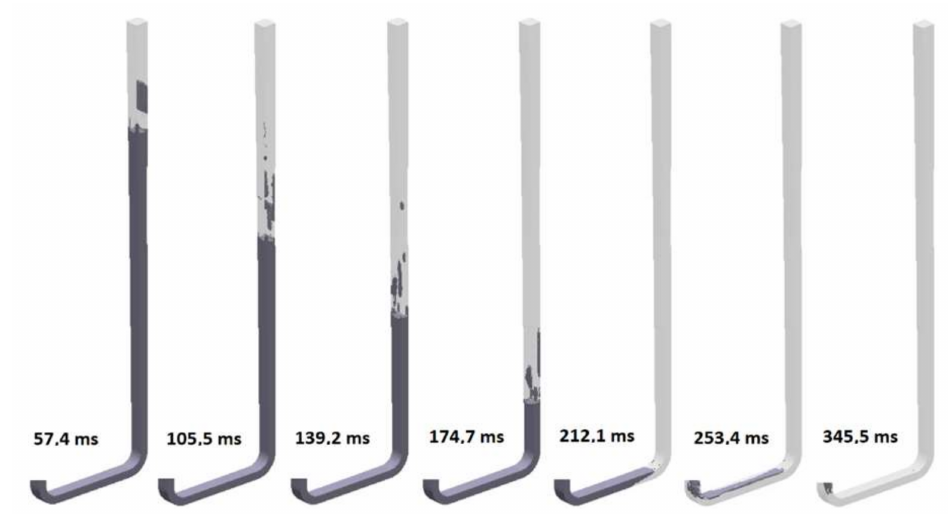
Figure 32. Air evacuation in thick rectangular sprue with hyperbolic taper (S s 8),